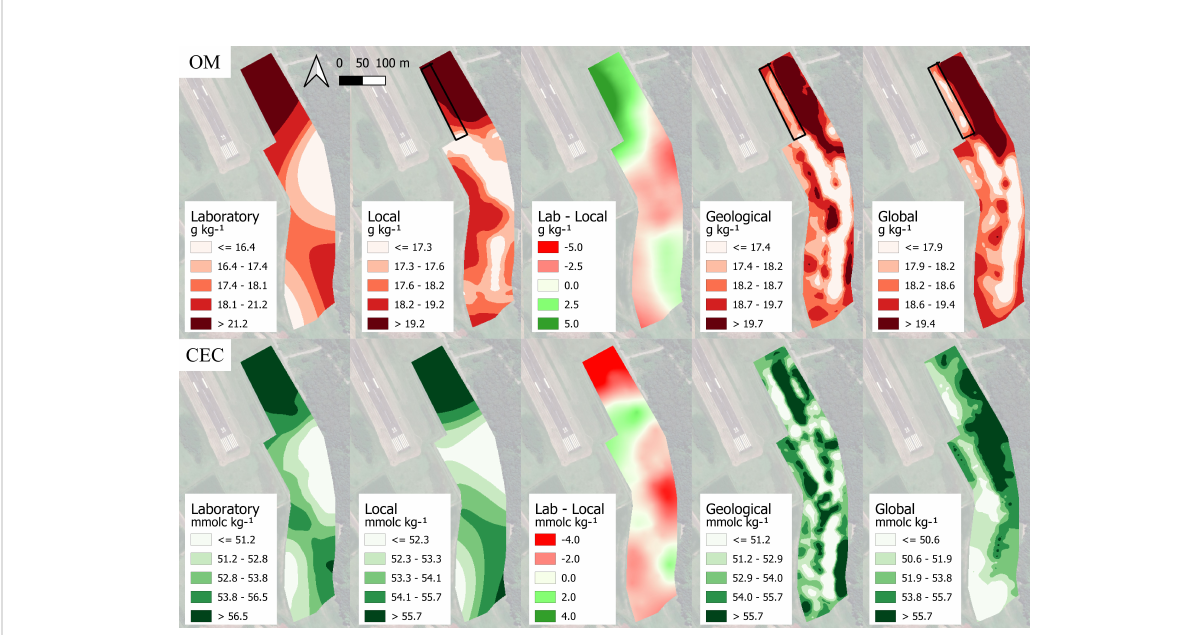
FIGURE 7 Maps of the fi ve quantiles obtained by ordinary kriging of organic matter (OM), in red, and cation exchange capacity (CEC), in green. Maps are presented in the order of: laboratory analysis; prediction model calibrated with only in- fi eld samples (local); difference of laboratory and local values (Lab − Local); prediction model calibrated adding samples from the same geological region (geological) and adding samples from different geological regions